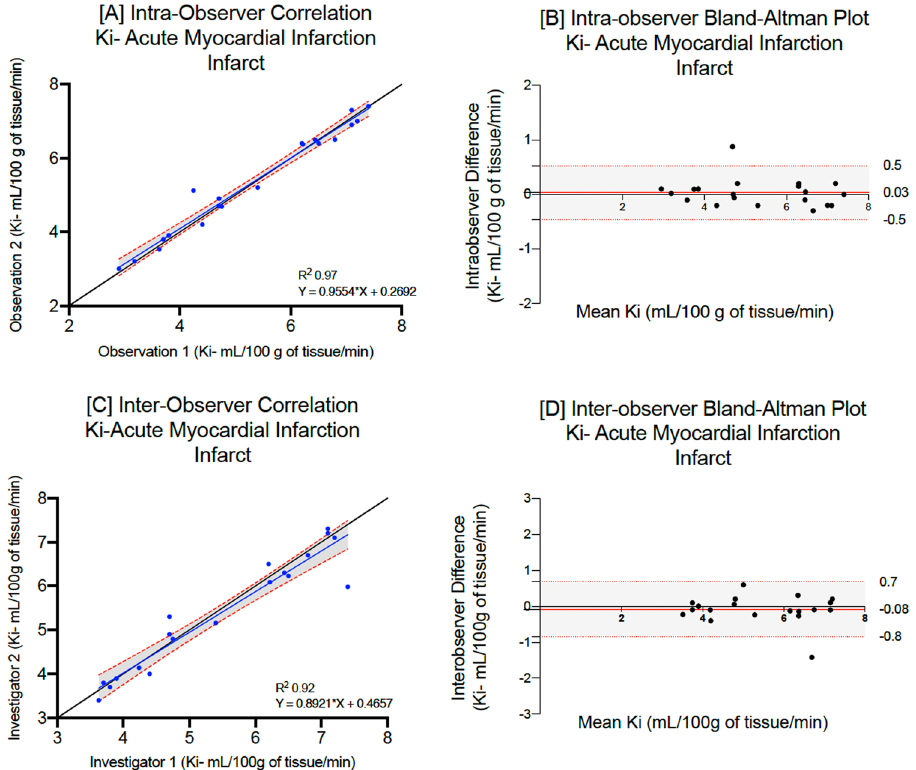
Figure 3. Intraobserver and interobserver repeatability of myocardial manganese uptake in acute myocardial infarction. Intra-observer linear regression analysis ( A ) and Bland–Altman plots for myocardial manganese uptake ( B ) in patients with acute myocardial infarction. Inter-observer linear regression analysis ( C ) and Bland– Altman plots for myocardial manganese uptake ( D ) in patients with acute myocardial